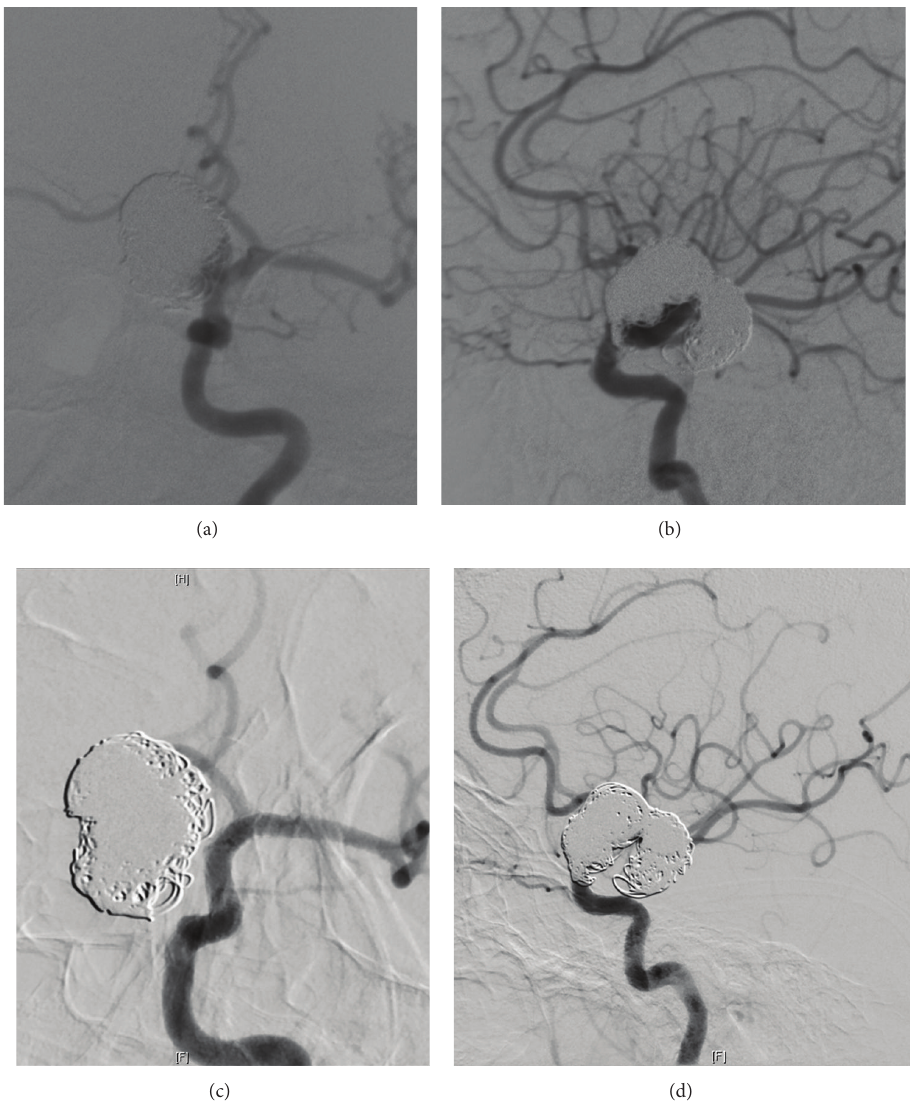
Figure 3: Arterial phase angiograms in (a) oblique and (b) lateral projections of a large (20mm) left supraclinoid internal carotid artery aneurysm that had recanalized after previous coil embolization. Follow-up angiogram 8 months after placement of pipeline embolization device, (c) oblique and (d) lateral projections, demonstrating complete occlusion of the aneurysm and patency of the ophthalmic artery that was covered by the flow